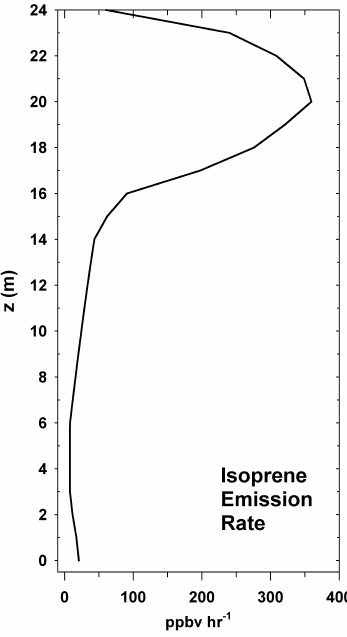
Fig. 4. Isoprene emission rate profile used in the Walker Branch Watershed forest canopy simulation for mid-July, 02:00p.m.LT (ppbvh − 1 )